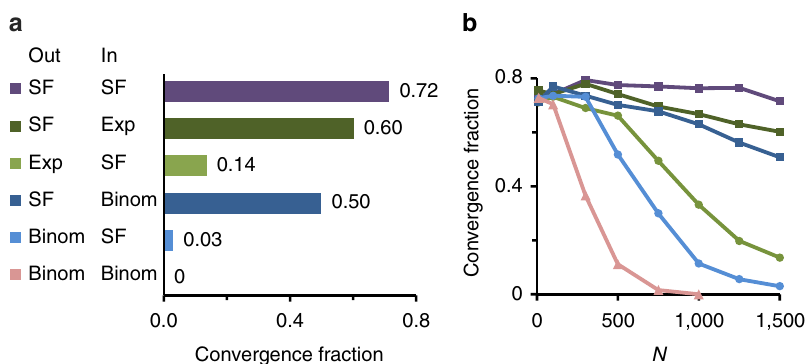
Figure 2 | Convergence fractions depend on network topology. ( a ) Seven ensembles of networks of size N ¼ 1,500 and different topologies exhibit remarkably different convergence fractions (CFs). Ensembles are characterized by the out- and in- degree distributions of the adjacency matrix T : ‘SF’, scale free distribution; ‘Exp’, exponential distribution; ‘Binom’, Binomial distribution. ( b ) CF as a function of network size for the same ensembles of ( a ) with matching colours. N ¼ 1,500, y (cid:5) ¼ 0, g 0 ¼ 10, D ¼ 10 (cid:2) 3 . Parameters for degree distributions: SF, ( a ¼ 1, g ¼ 2.4); Binom, p ’ 3 : 5